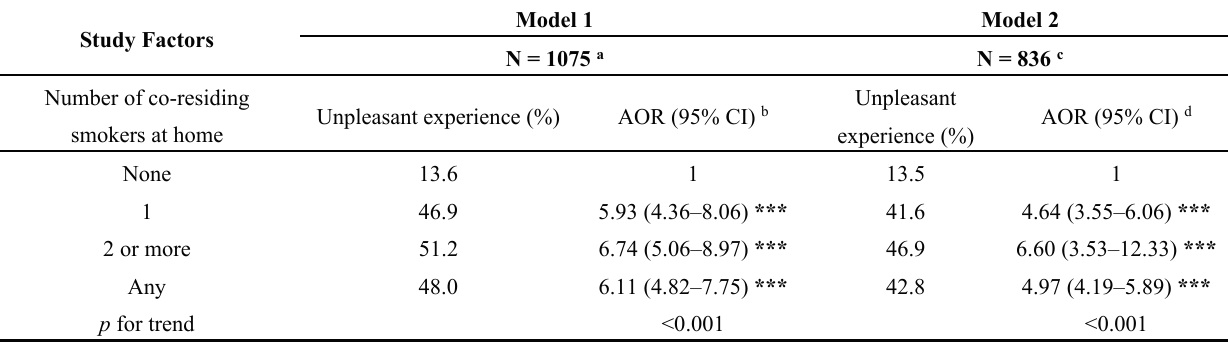
Table 2. Adjusted odds ratio (AOR) of tobacco-related unpleasant experience by family smoking and secondhand smoke (SHS) exposure at home in primary students in Hong